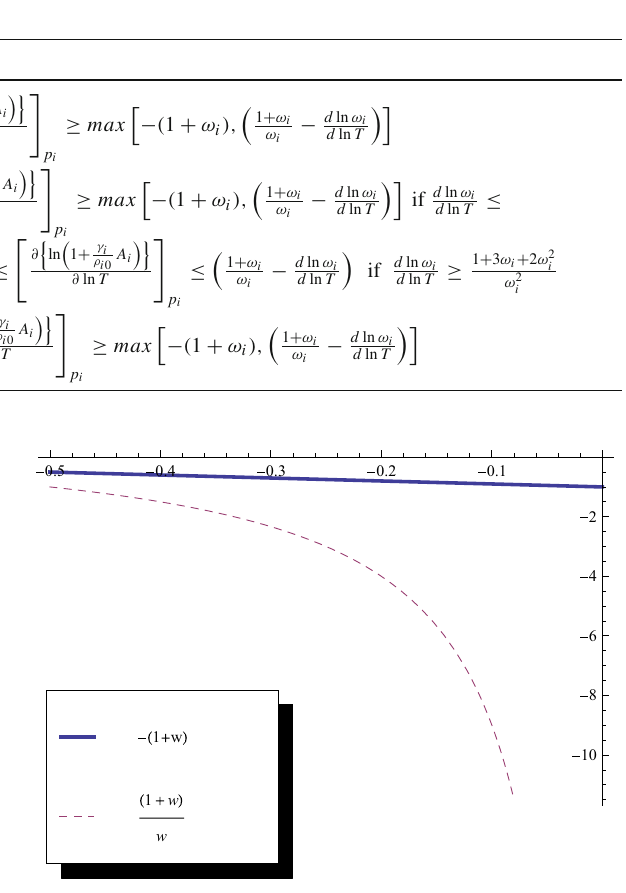
Fig. 1 No point having value greater than − ( 1 + ω i ) and less than 1 + ω i ω i